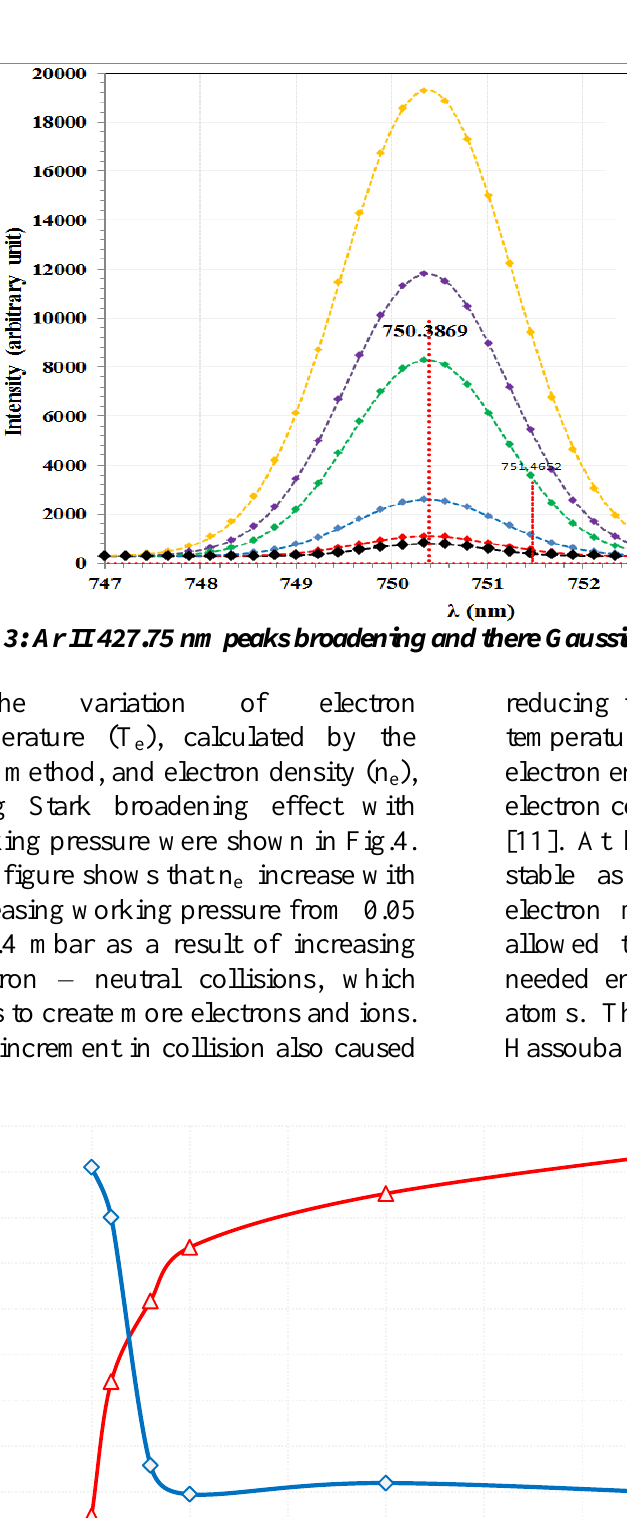
and (b) n for RF plasma in Ar with different working e e